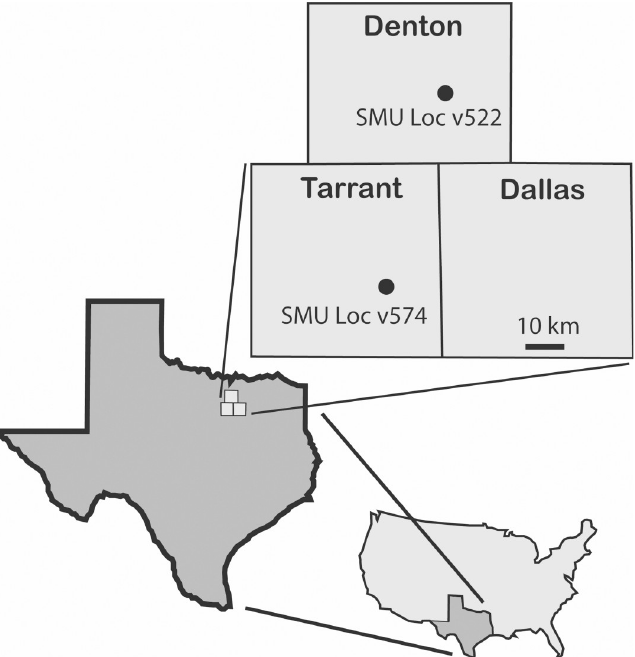
Fig 1. Map with the two localities (SMU Loc v522, SMU Loc v574) in the counties of north central Texas that have yielded remains of Mawsonia sp.